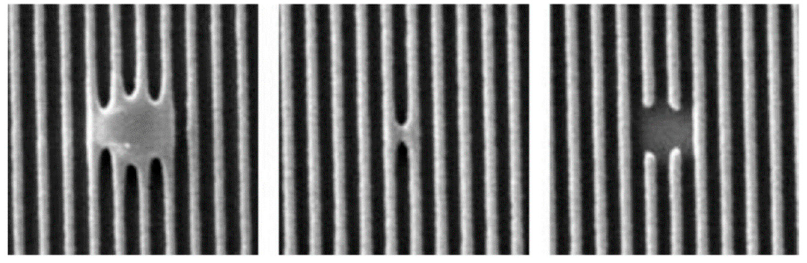
Figure 2. Examples of photolithography faults in IDT structure.